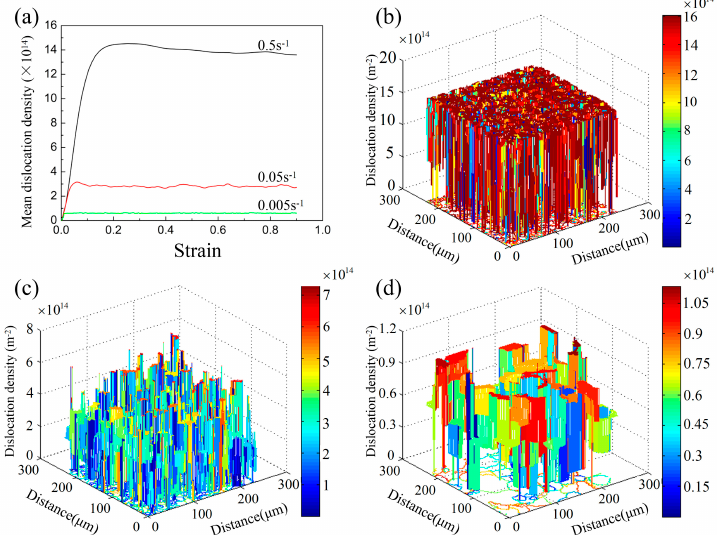
Figure 11. Dislocation density of FeMnSiCrNi SMA under DRX at the various strain rates at 850 °C based on CA: ( a ) variation of dislocation density with strain; ( b ) ε = 0.9, 0.5 s − 1 ; ( c ) ε = 0.9, 0.05 s − 1 ; ( d ) ε = 0.9, 0.005 s − 1 .